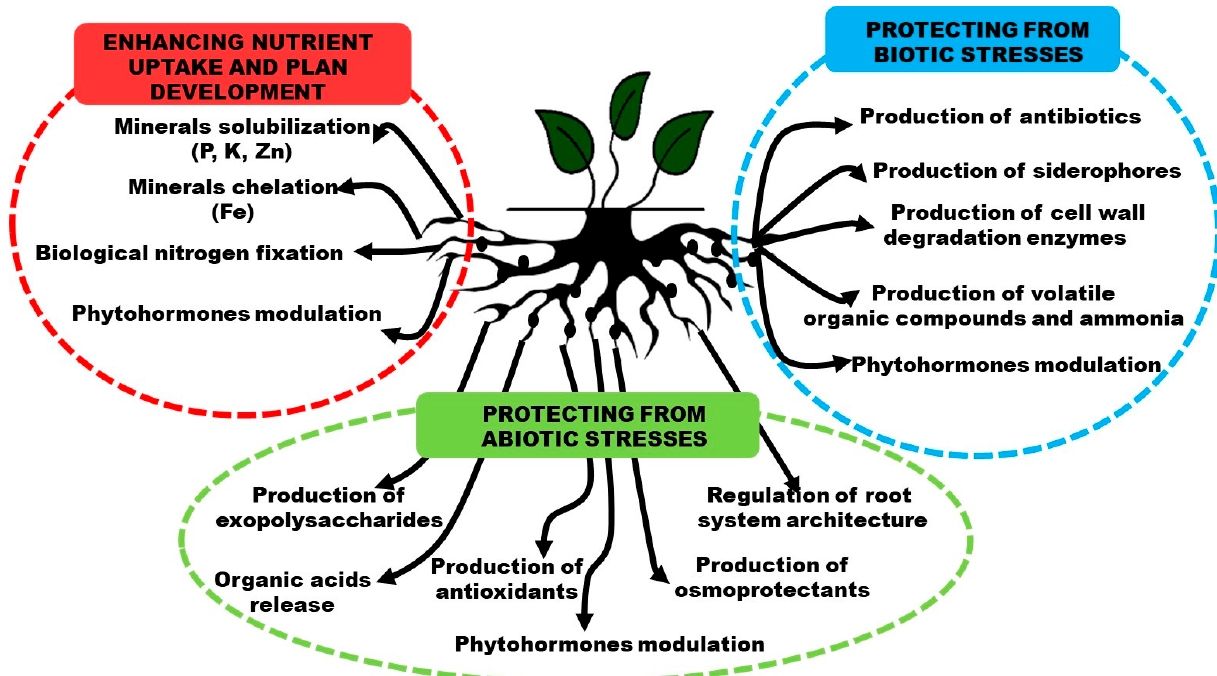
Figure 1. Overview of the major mechanisms used by PGPB to enhance nutrients uptake and plant development, as well as to protect plants from biotic and abiotic stresses.